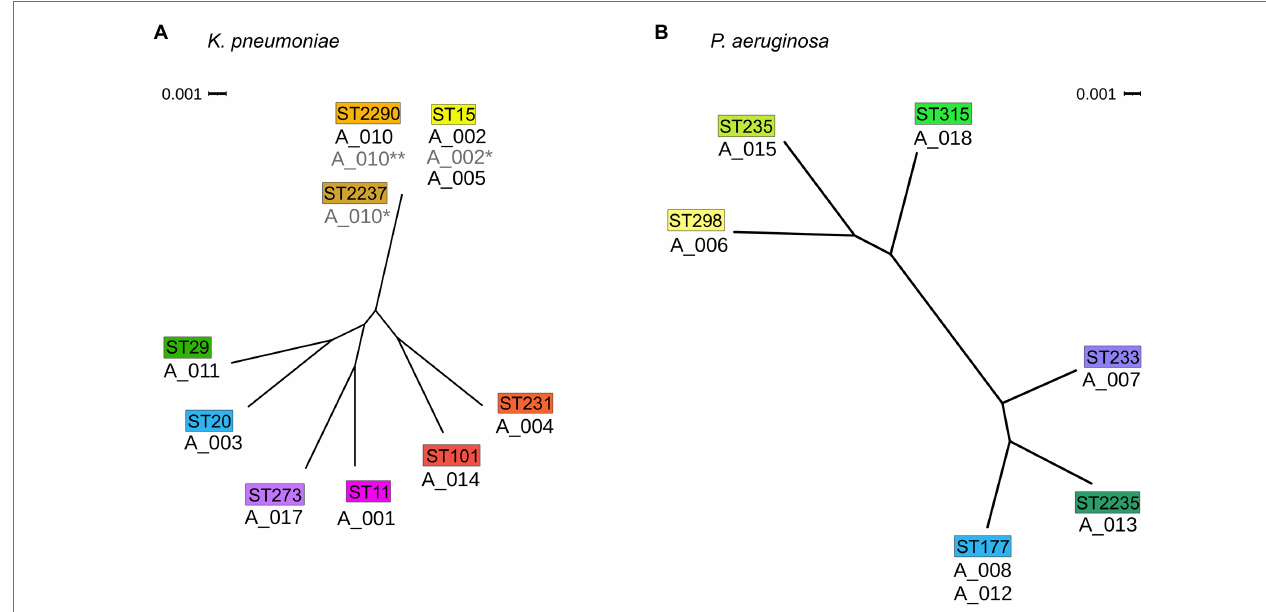
FIGURE 3 | Phylogenetic relatedness of isolates. (A) Phylogenetic tree of K. pneumoniae isolates and (B) P. aeruginosa isolates of this study both in radial view. The corresponding MLST types are drawn above the isolates in colored boxes. Scale bar: phylogenetic distance.